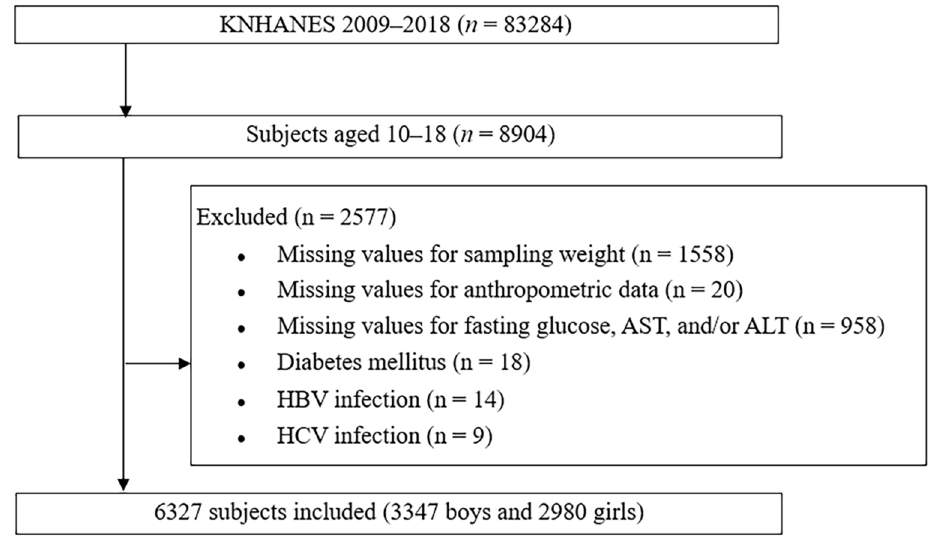
Figure 1. Design and flowchart of study population. KNHANES: Korea National Health and Nutrition Examination Survey; AST: aspartate aminotransferase; ALT: alanine aminotransferase.